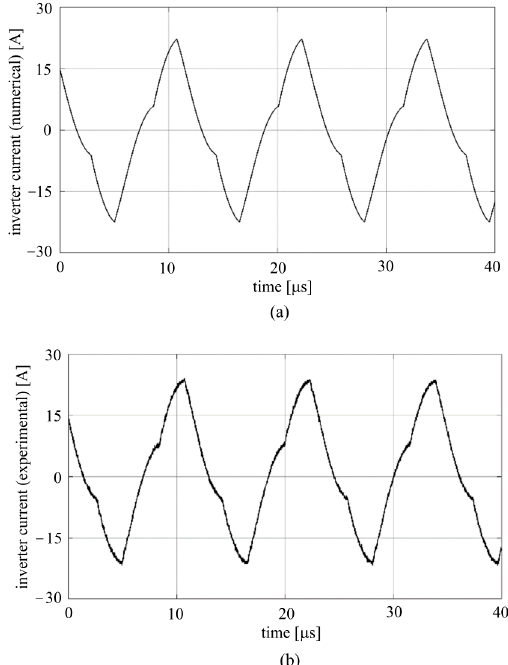
Figure 15. Output inverter current when a power load equal to a 3.5 kW is requested to IPT system: ( a ) numerical result; ( b ) experimental result. Finally, Figure 16 reports the measured time waveform of the instantaneous power entering the DC/DC converter. In this case again, the measured quantity is in excellent agreement with the predicted one.